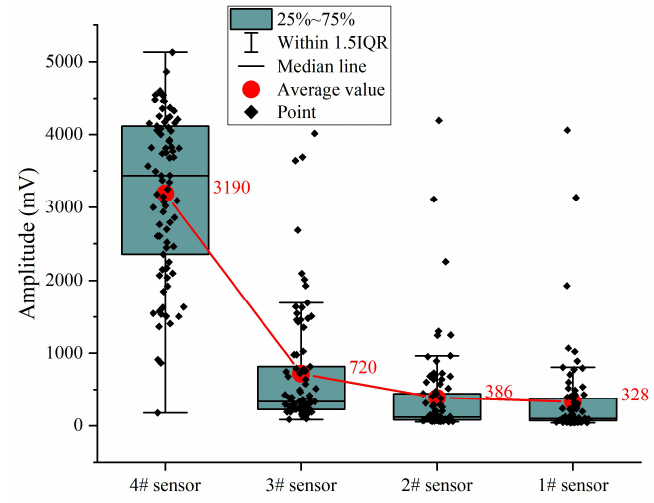
Figure 7. Statistical box line diagram of amplitude attenuation.